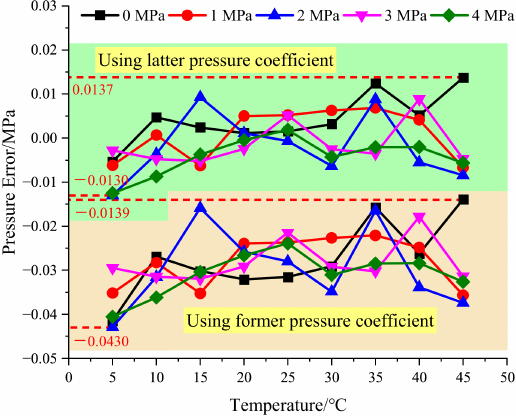
Figure 12. Pressure errors using the latter and former pressure-wavelength